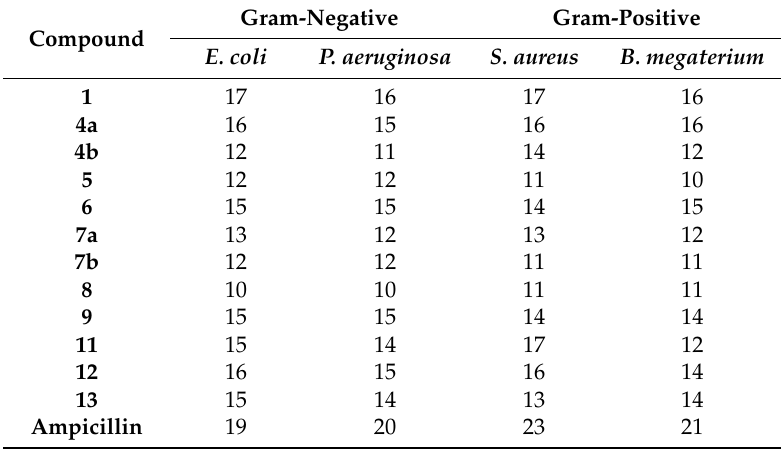
Table 2. Effect of novel compounds on Gram-negative and Gram-positive microorganisms. The results are expressed as zone inhibition in mm